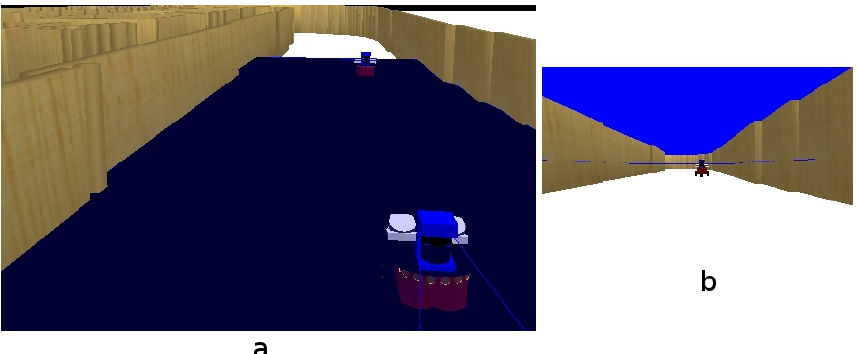
Figure 17. ( a ) Situation; ( b ) On board current